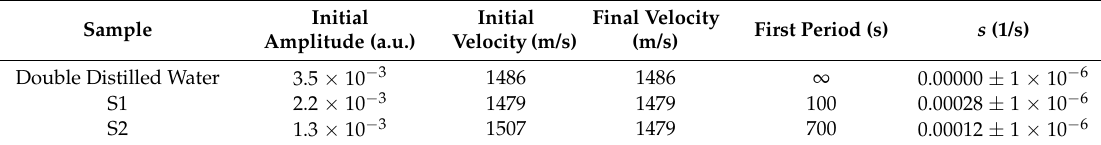
Table 1. Stability parameter for the tested